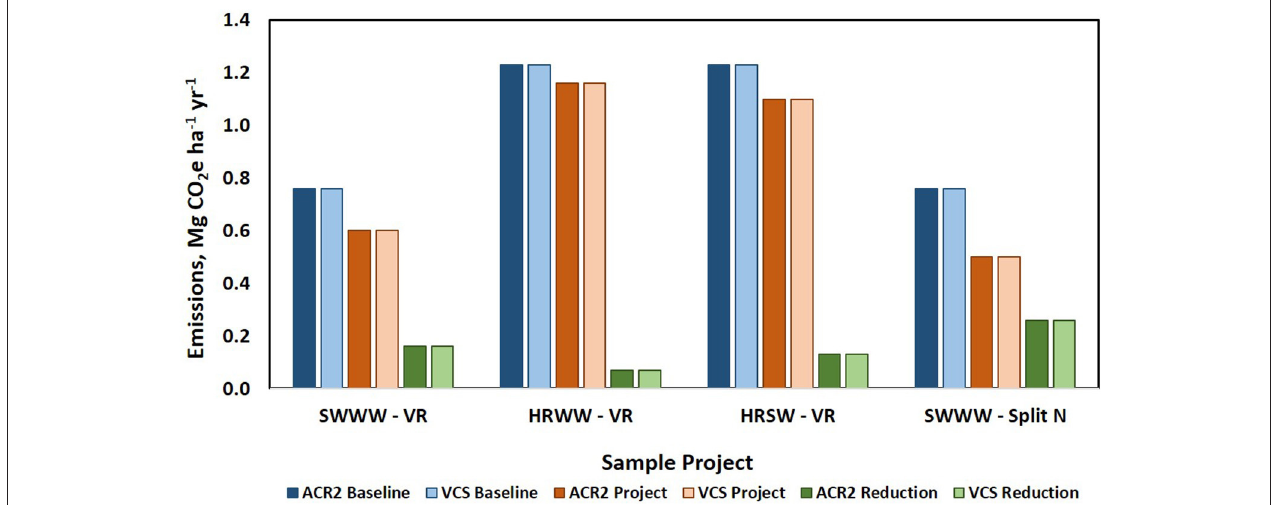
FIGURE 2 | Baseline, Project, and Offset (Reduction) Emissions by American Carbon Registry (ACR2) and Verified Carbon Standard (VCS) Protocols. For quantification used field scale data from Cook Agronomy Long-term Agroecosystem Research Farm, IPCC Tier I direct emission factors, and IPCC default indirect emission factors to determine N 2 O emission reductions from management changes for: SWWW-VR, soft white winter wheat uniform to variable rate N (Sample Project 1); HRWW-VR, hard red winter wheat uniform to variable rate N (Sample Project 2); HRSW-VR, hard red spring wheat uniform to variable rate N (Sample Project 3); and SWWW-Split N from all fall to split N application between fall and spring (Sample Project